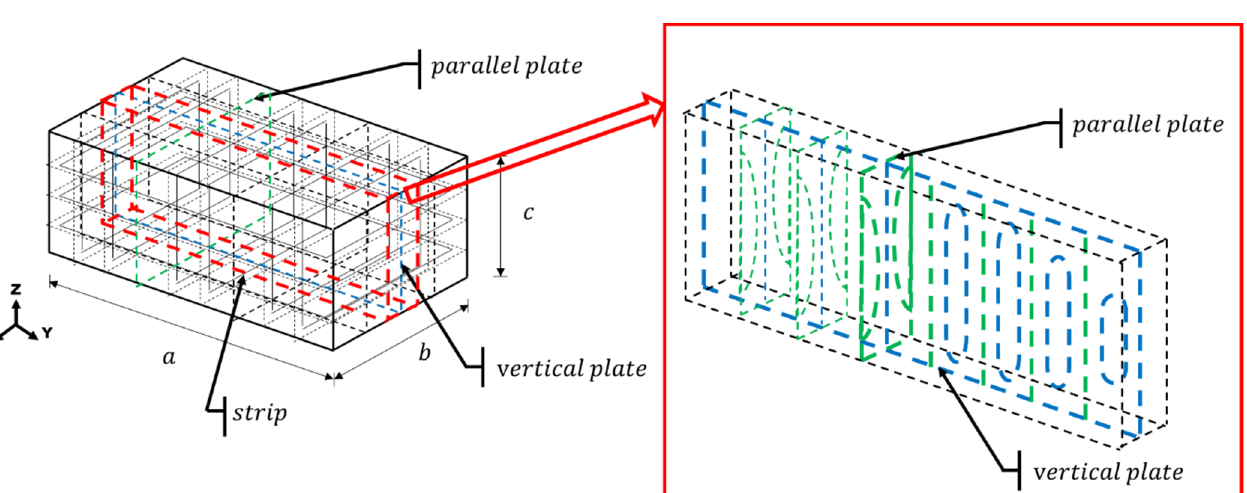
Table 2. Design variables for time-dependent structural reliability analysis.